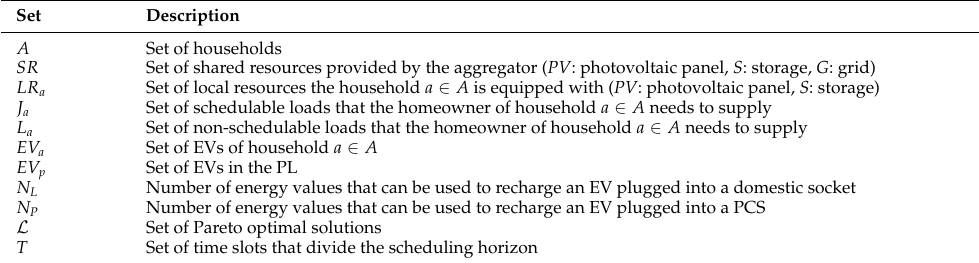
Table 2. Sets considered in the mathematical formulation.